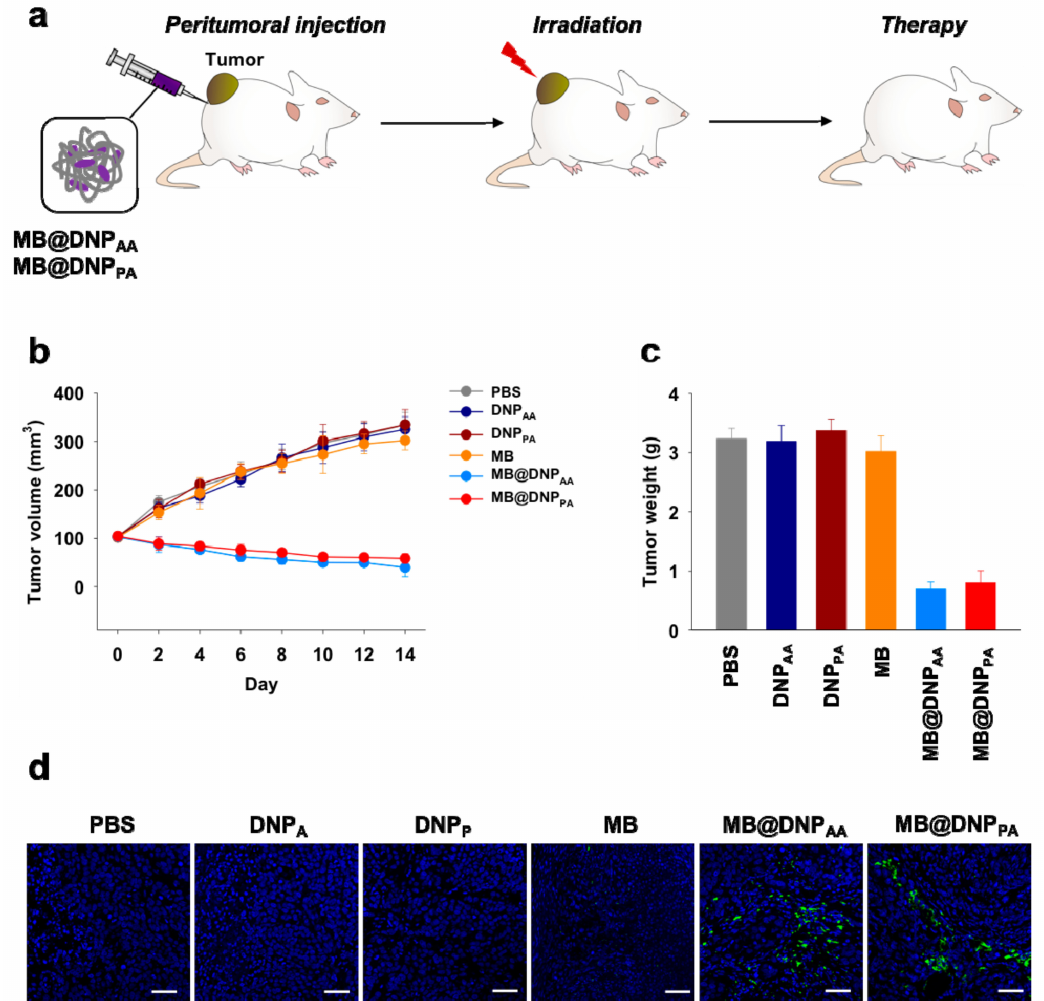
Figure 5. ( a ) Schematic presentation of in vivo PDT using MB@DNPs. ( b ) In vivo tumor growth profiles of mice treated with PDT using MB (orange), MB@DNP AA (blue), and MB@DNP AP (red). The gray circles represent untreated mice. The results indicate mean ± s.d. ( n = 5). ( c ) Ex vivo weights of the excised tumor tissues 14 days post-treatment. ( d ) Histological images of the tumor tissues after staining with Hoechst 33458 (nuclei, blue) and fluorescein-labeled annexin V (apoptotic cells, green). Scale bar: 50 µ